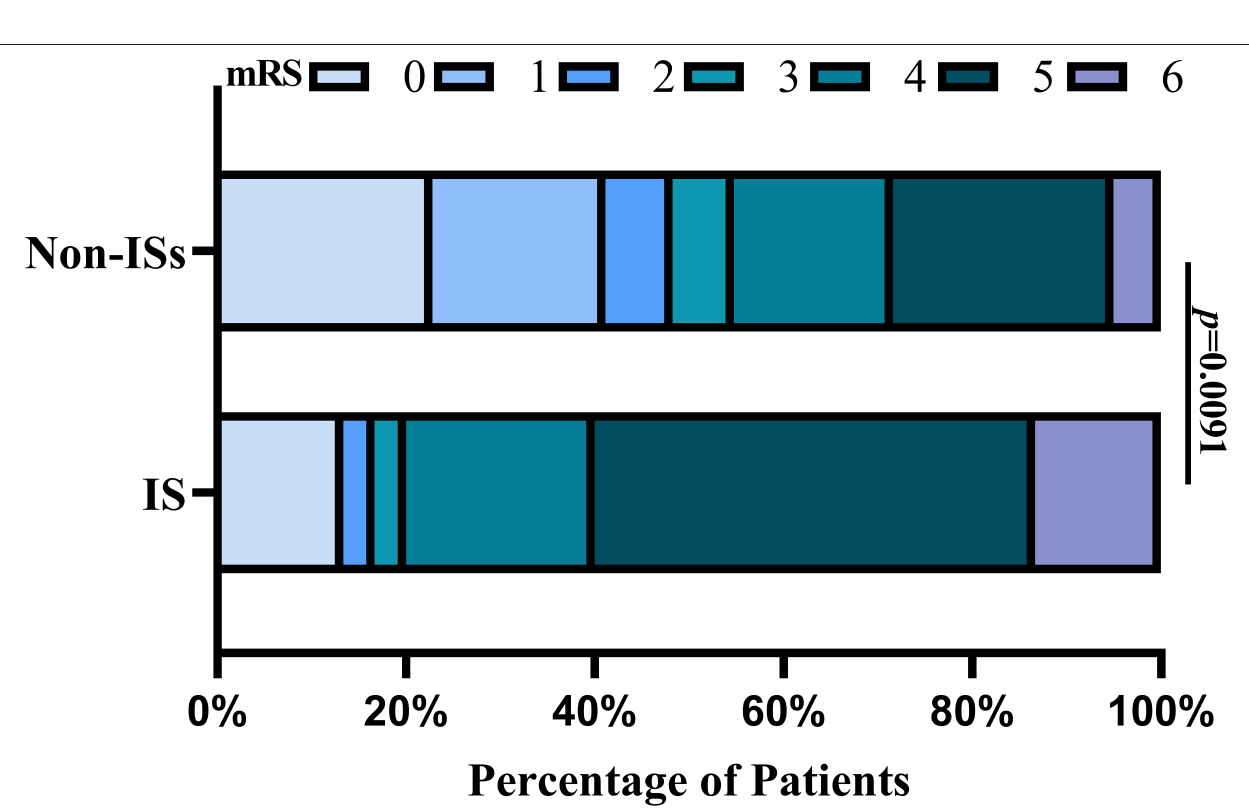
FIGURE 4 | Distributions of mRS scores at 90 days between the ISs and non-ISS groups. Proportions of patients within each score category on the 7-point scale (where o indicates no symptoms and 6 indicates death) at 90 days. ISs, immediate seizures; mRS, modified Rankin Scale.